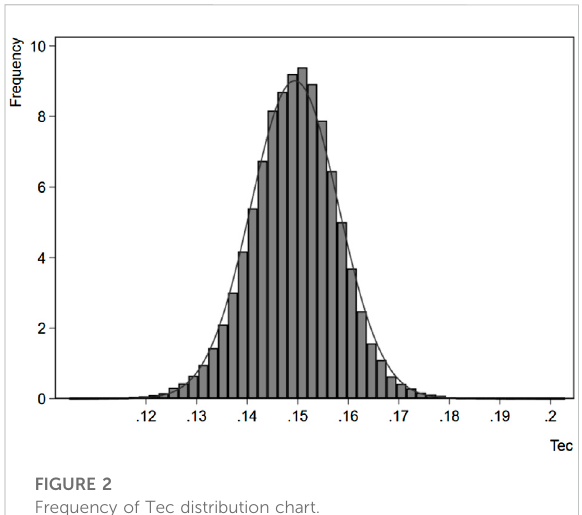
FIGURE 2 Frequency of Tec distribution